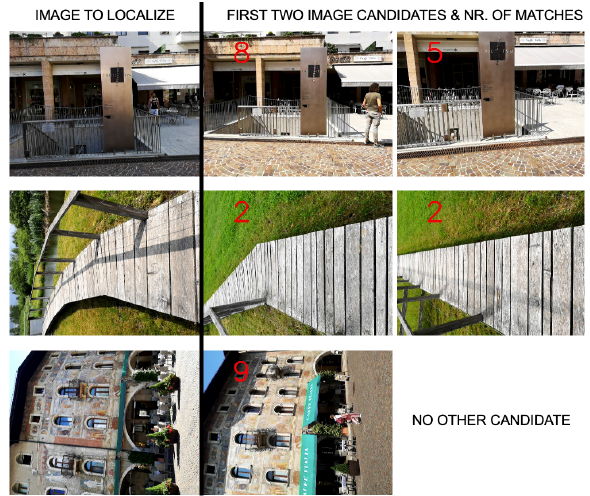
Figure 8 . Examples of localization problems due to scene changes. The algorithm can retrieve wrong localization candidates (middle) and/or candidates with an insufficient number of matches (top,